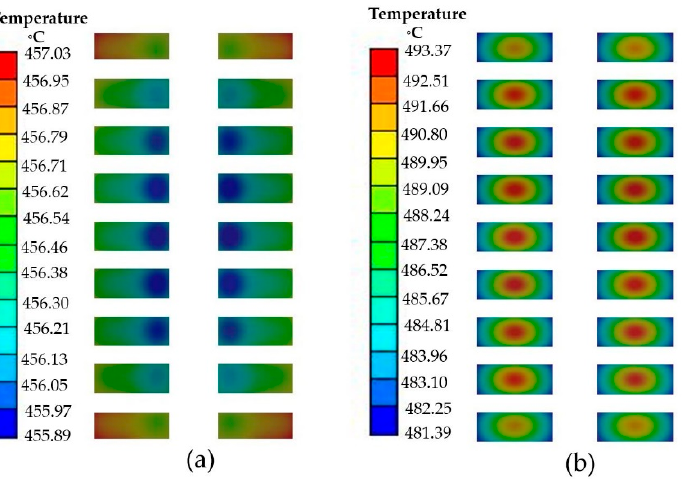
Figure 16. Temperature distributions in the connecting areas for ( a ) series and ( b ) parallel WTs at the time with the maximum temperatures and 0.5 N of force. To analyze the occurrence of misaligned defects in Figures 3d, 17 and 18 present the total deformation from the structural simulation for the series and parallel WTs, respectively, in the same color scale: (a) overviews and (b) sketch pictures focusing on connecting areas in the yz plane. In (a), as expected, the maximum total deformation was in